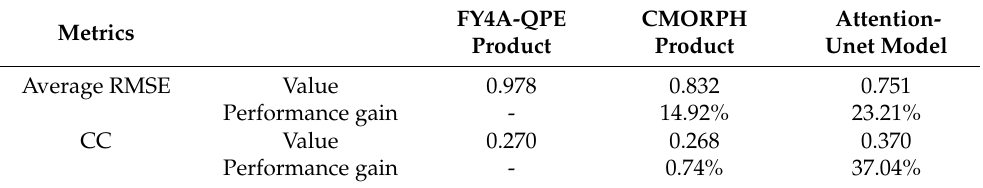
Table 5. Summary of precipitation estimation performance over the verification periods. Metrics